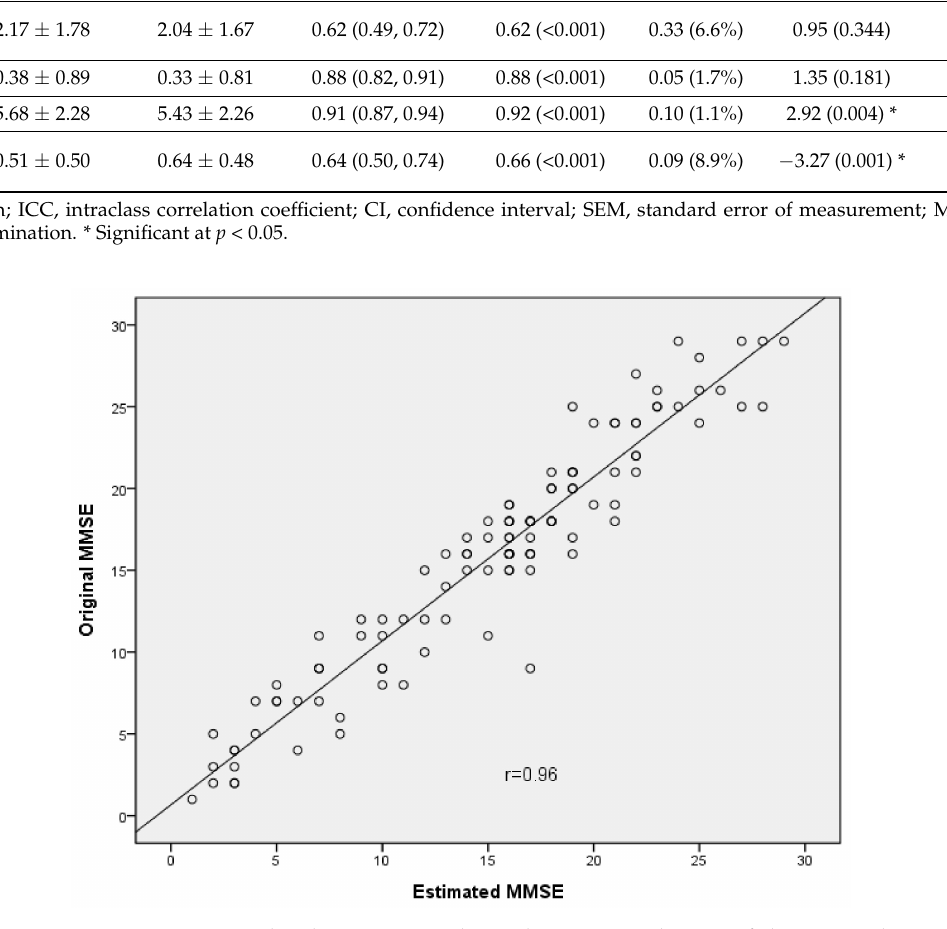
Figure 1. Scatter plot depicting correlation between total score of the Original MMSE and the Estimated